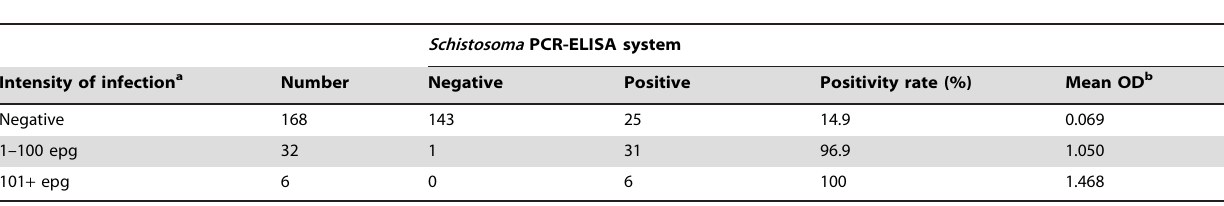
Table 2. Results obtained with the Schistosoma PCR-ELISA system grouped into two levels of intensity of infection.